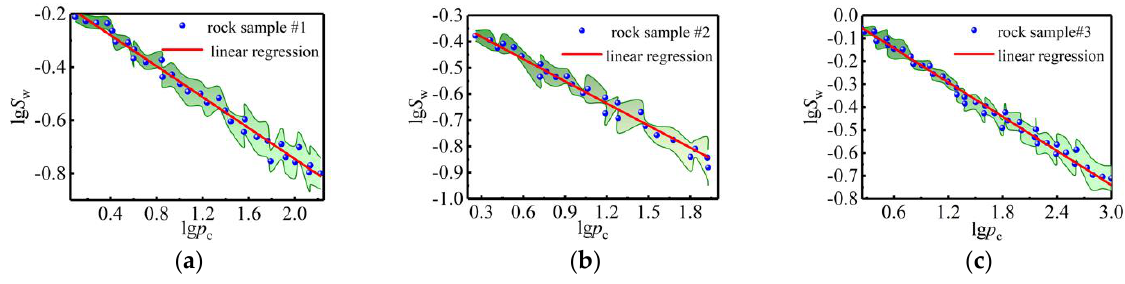
Figure 1. Linear regression of the experimental data of the coal rock samples. ( a ) rock sample #1, ( b ) rock sample #2, ( c ) rock sample #3.